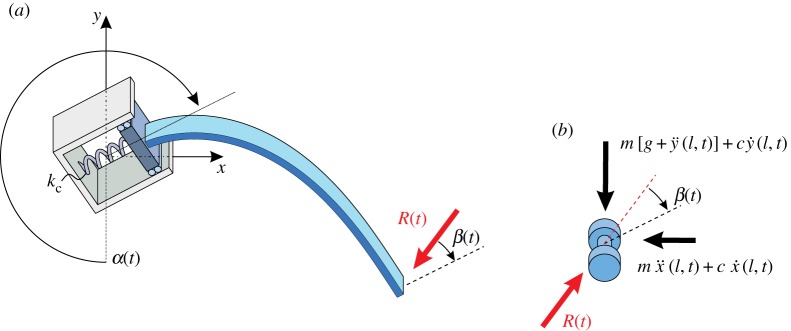
Free-body diagram of the massless rod model: schemes of the massless elastic rod (a) and the lumped mass (b). Regularization of the solution obtained with this simplified model is achieved through the introduction of the viscous coefficient c owing to air drag and the finite stiffness kc of the clamp. (Online version in colour.)